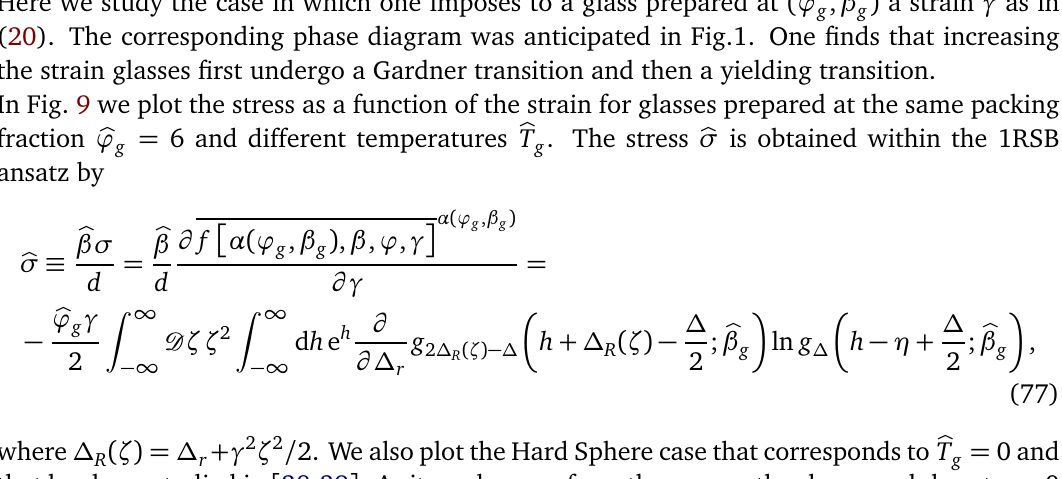
Figure 9: The equation of state of different glasses prepared at ( when a shear strain is applied. For sufficiently strong strain each glass undergoes a Gardner transition (black dots) and then a yielding transition. The parts of the curves right after the Gardner transitions are just an approximation since they are computed within a 1RSB ansatz which is